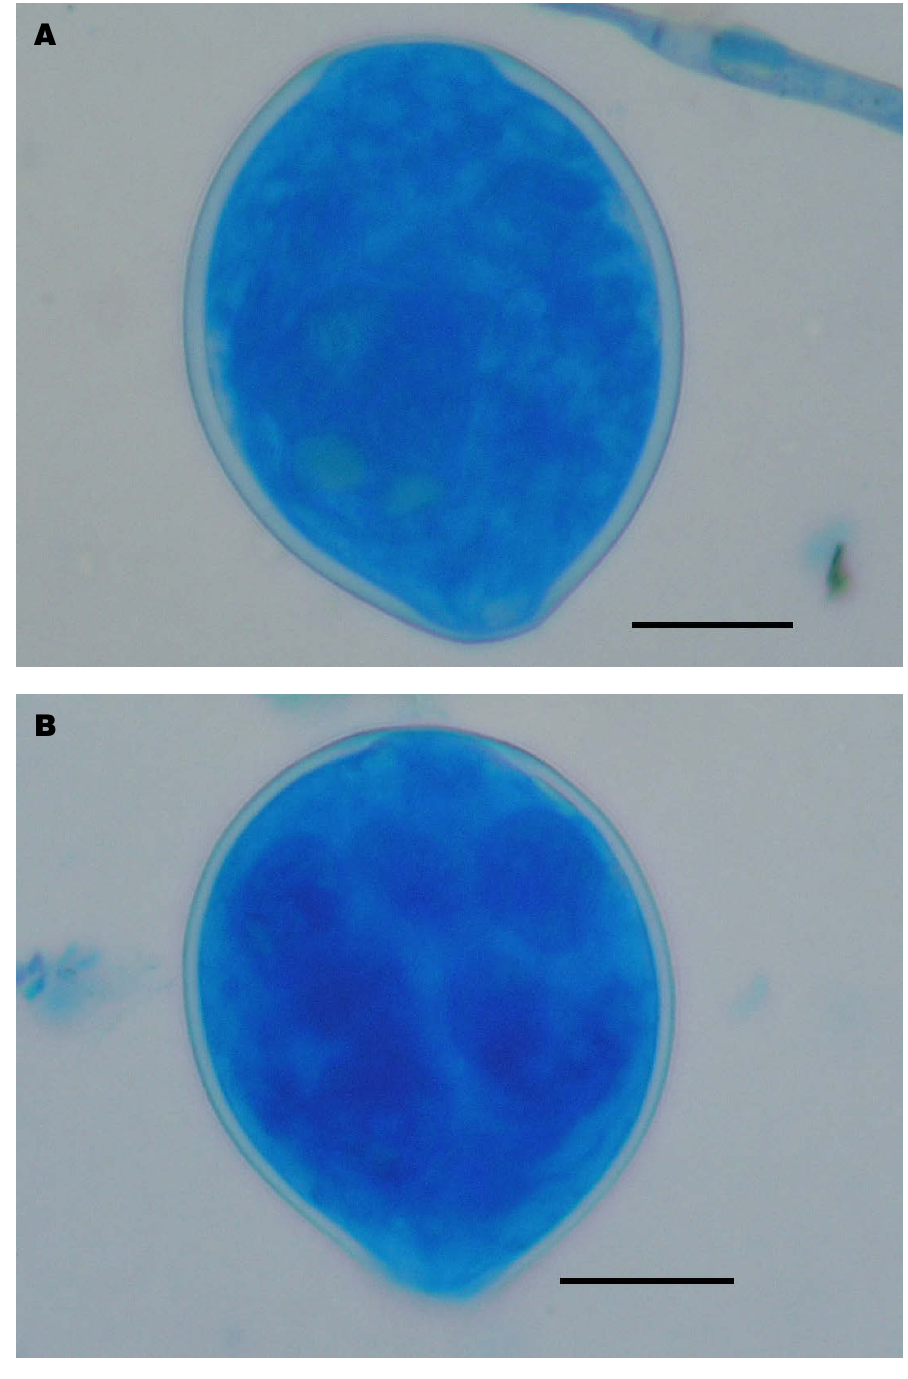
Fig. 2. A – ascus of Podosphaera xanthii; B – ascus of Podosphaera fusca, scale bar = 20